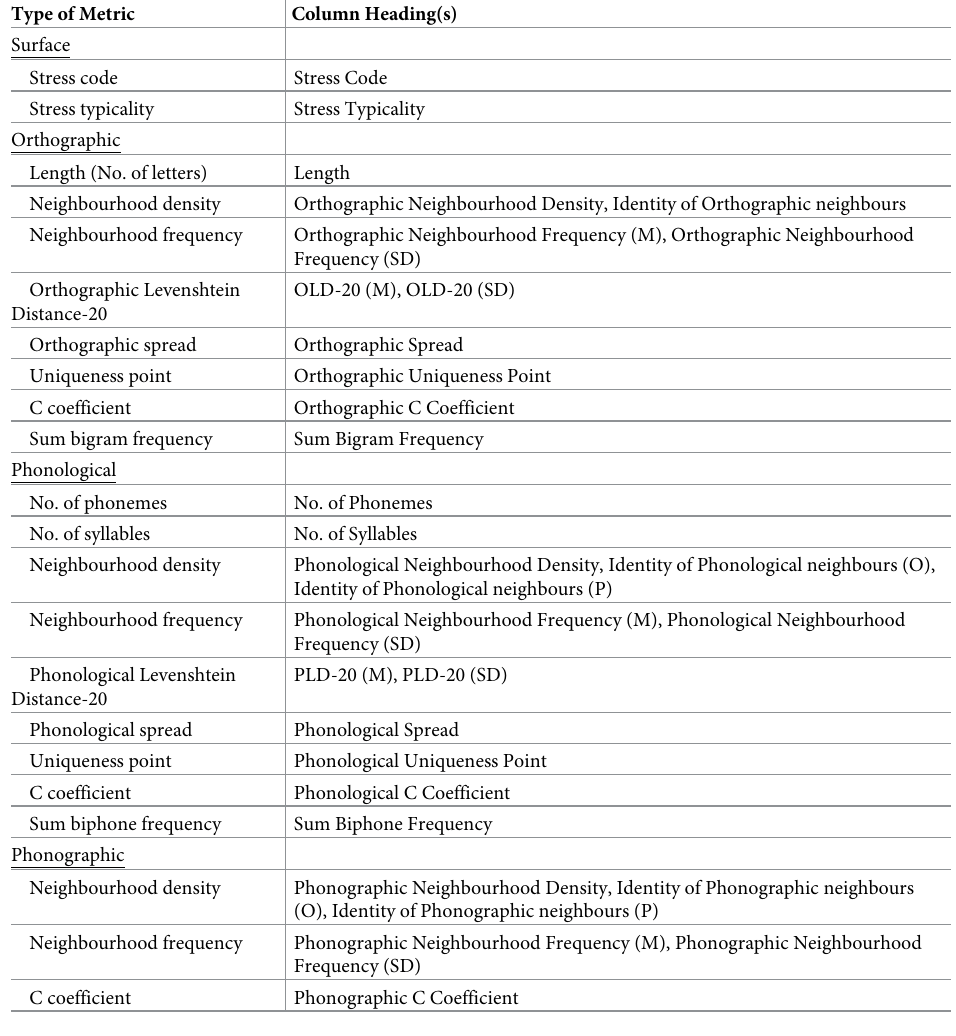
Table 3. Column headings for each metric in the output